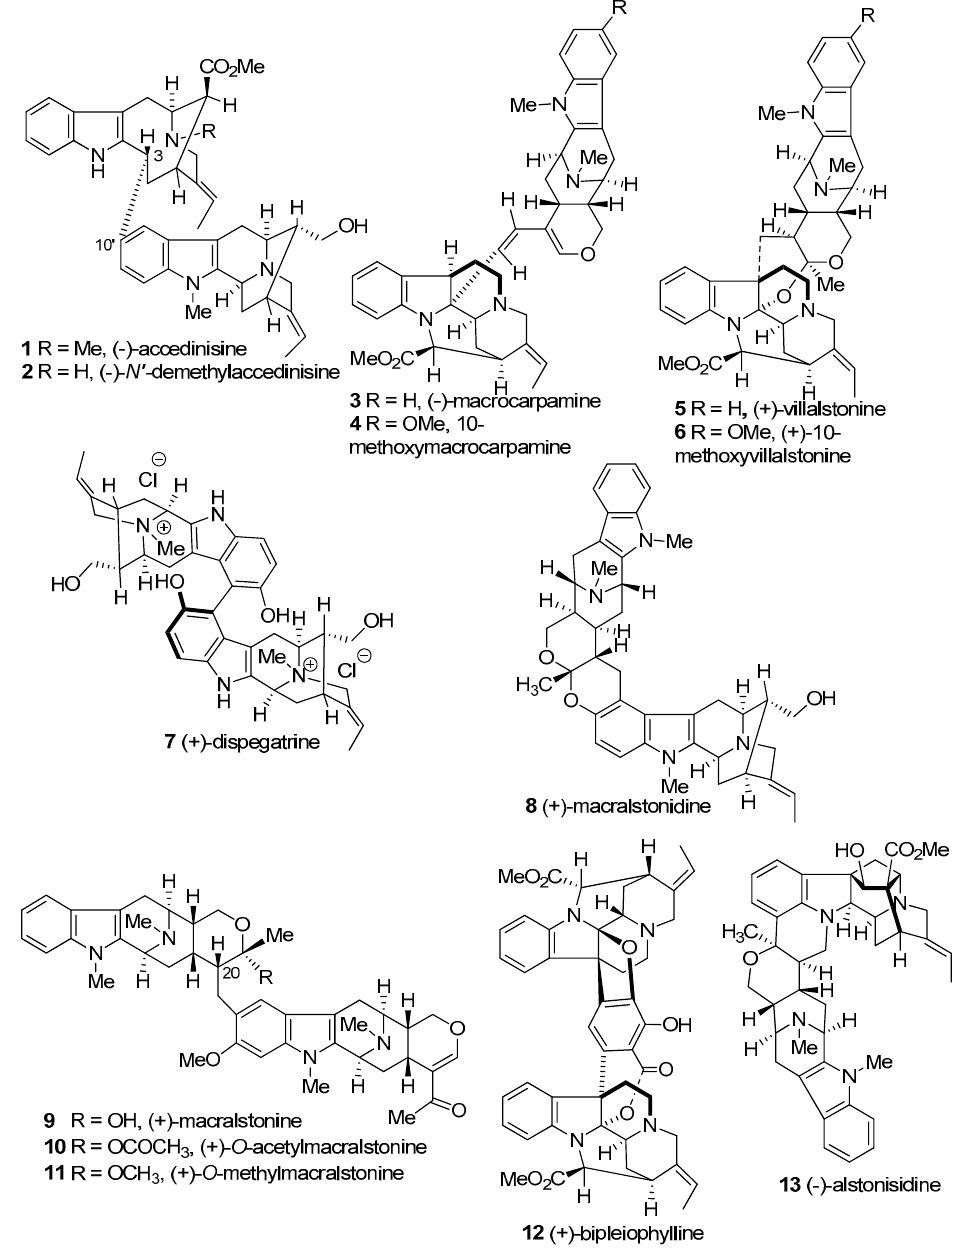
Figure 1. Representative examples of bioactive bisindole alkaloids.